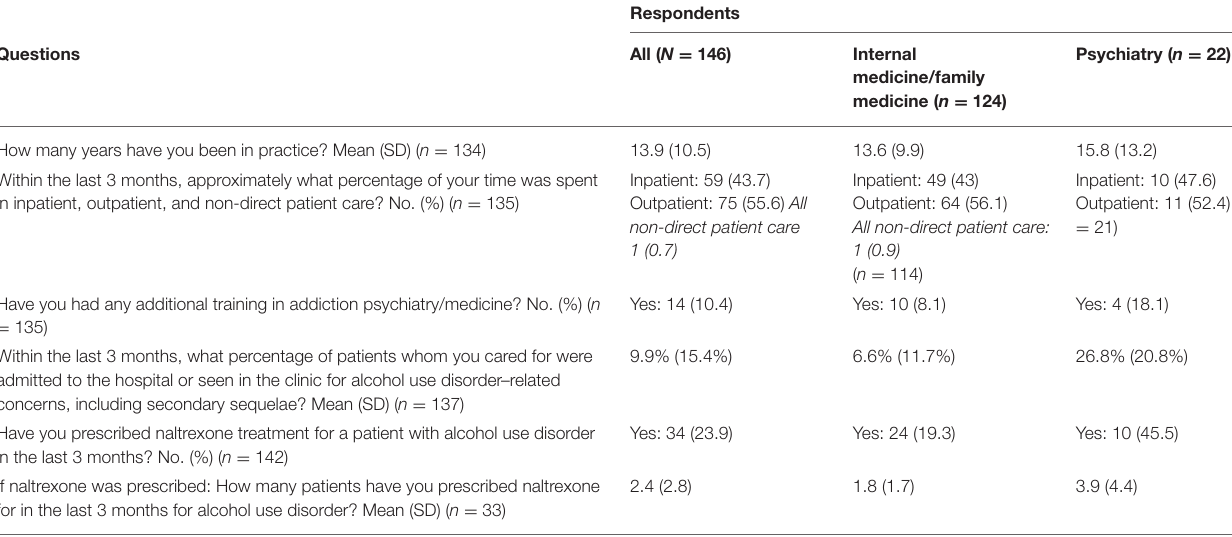
TABLE 1 | Demographic information and prescribing patterns.